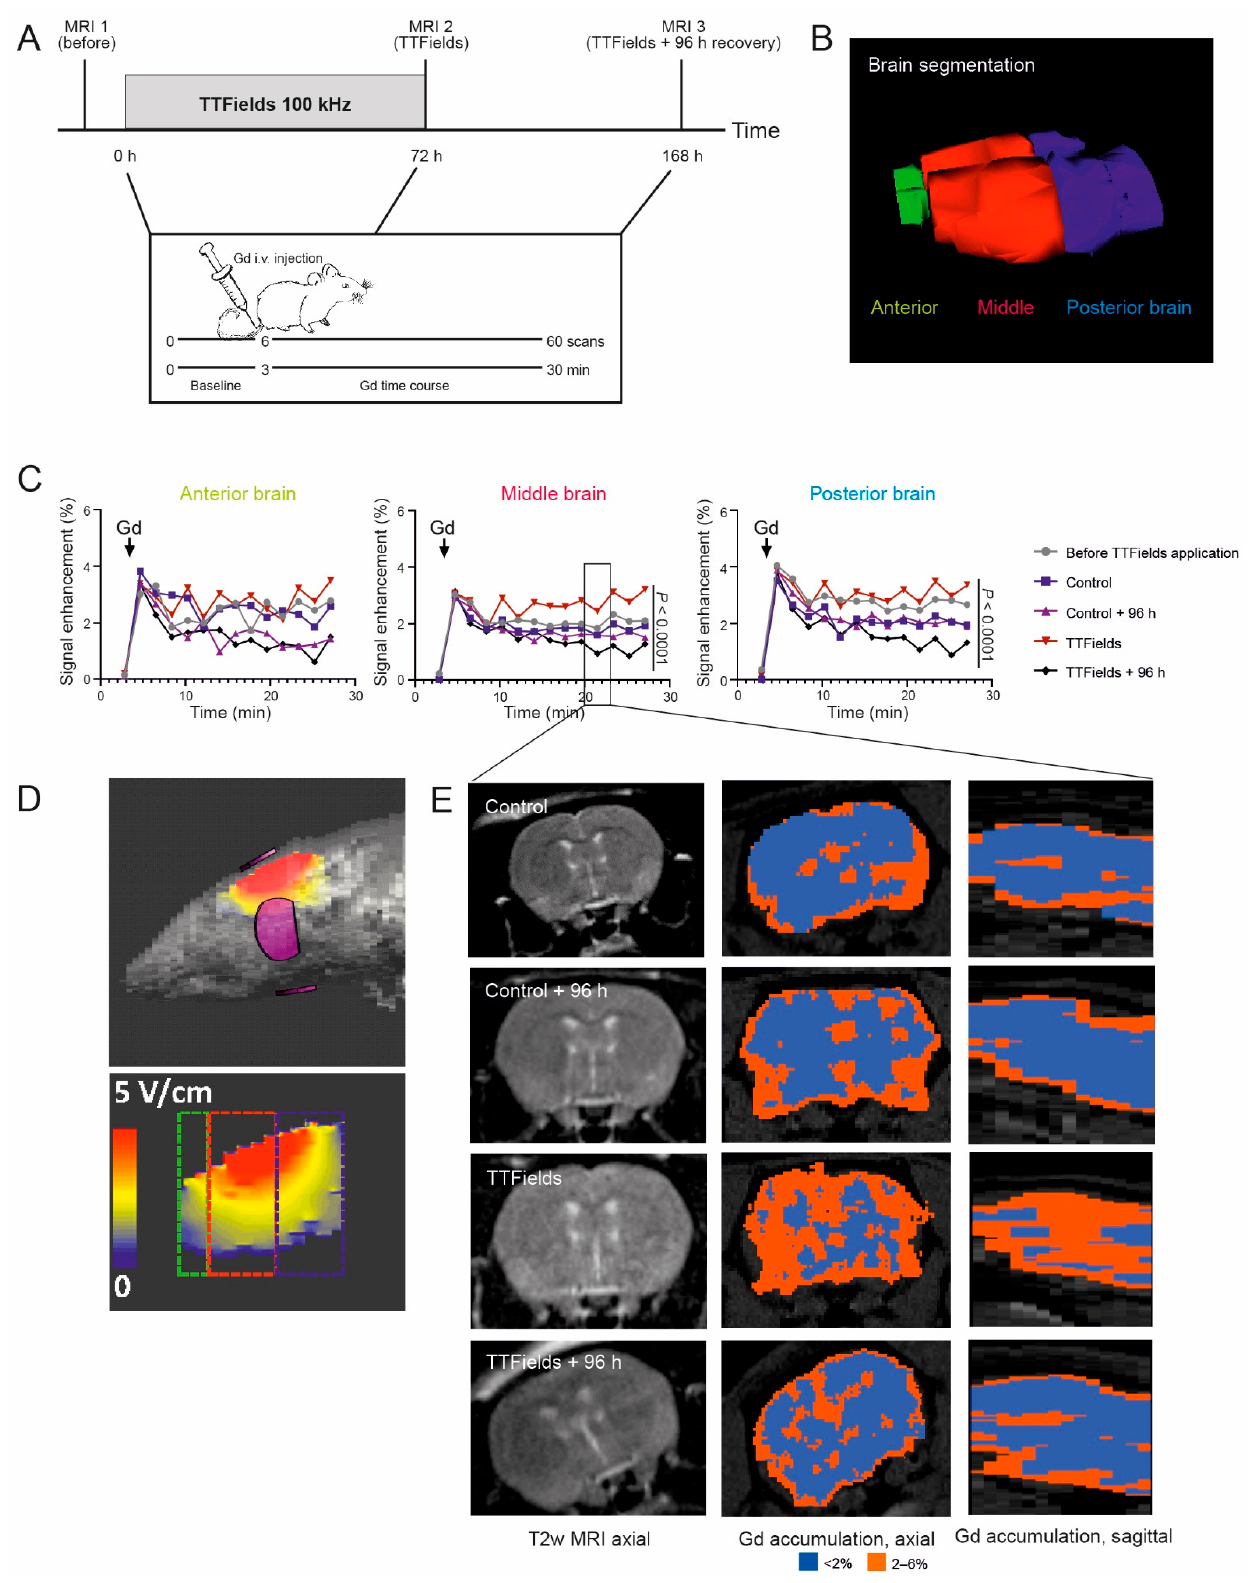
Figure 5. TTFields treatment led to transient Gd uptake into the rat brain. ( A ) Schematic represen- tation of the experimental setup. ( B ) 3D representation of the brain segmentation: green = anterior, red = middle, and blue = posterior brain. ( C ) Time course DCE-MRI of Gd contrast agent in the